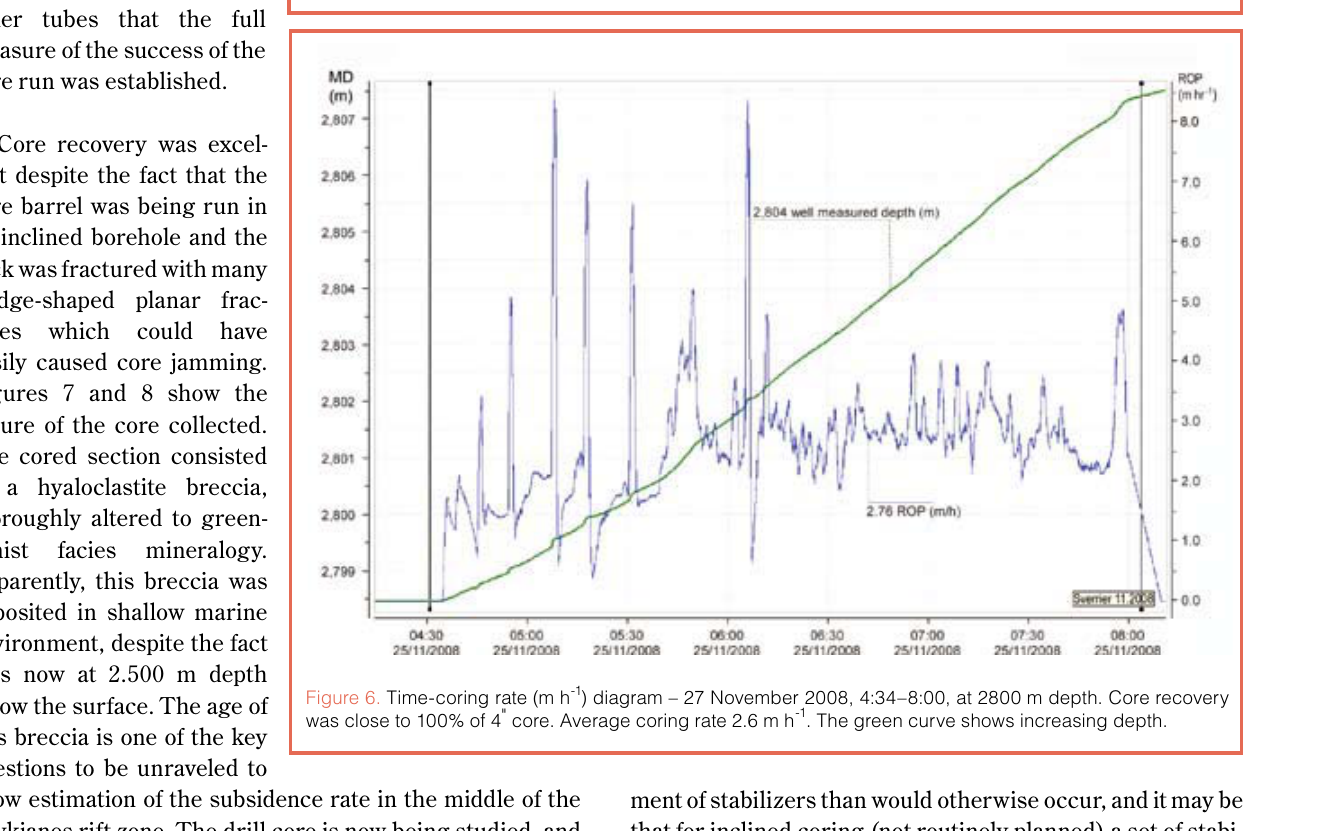
Figure 5. Weight on bit (WOB) (t), torque (dNm) and revolution (RPM) diagram during the test coring